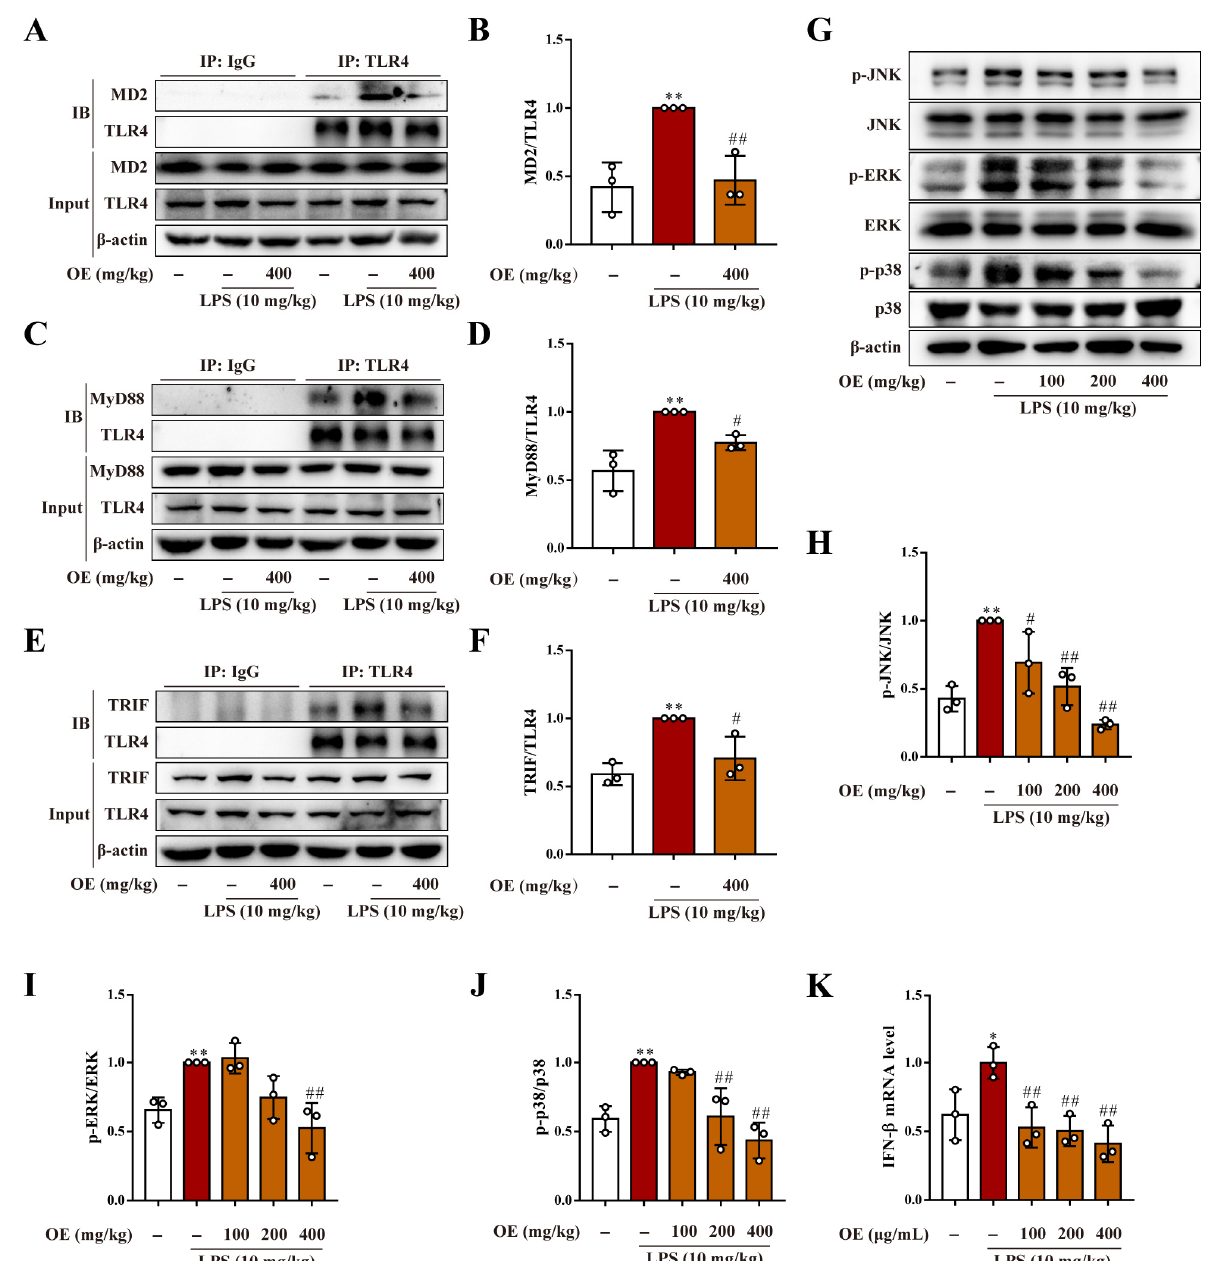
Figure 8. OE blocked TLR4/MD2 complex formation in AKI mice. ( A – K ) Mice were administered OE (100, 200, 400 mg/kg) by gavage for 7 days followed by the intraperitoneal injection of LPS (10 mg/kg) and feeding for another 12 h. TLR4/MD2 ( A , B ), TLR4/MyD88 ( C , D ), and TLR4/TRIF ( E , F ) complex formation in mice kidneys were determined by a co-immunoprecipitation assay. Protein expression of p-JNK, JNK, p-ERK, ERK, p-p38, and p38 ( G – J ) in mice kidneys was analyzed by a western blotting analysis. The mRNA level of IFN- β in mice kidney was determined by quantitative real time PCR analysis. Data presented as Means ± SD. * p < 0.05, ** p < 0.01 vs. control group; # p < 0.05, ## p < 0.01 vs. LPS group; ns, no